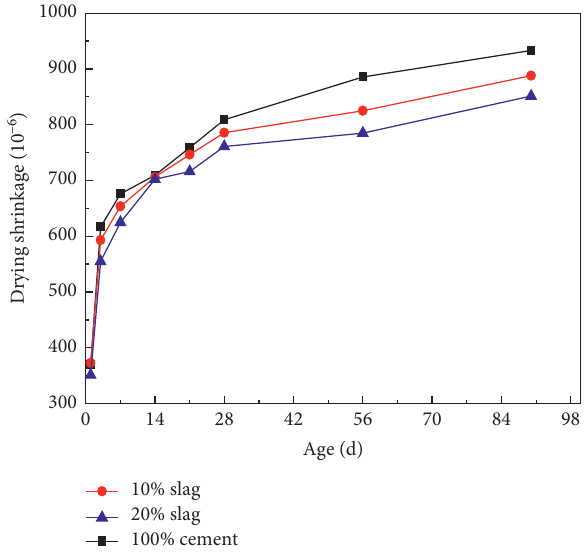
Figure 19: Effect of PCE-2 and metakaolin dosage on drying shrinkage of cement mortar.